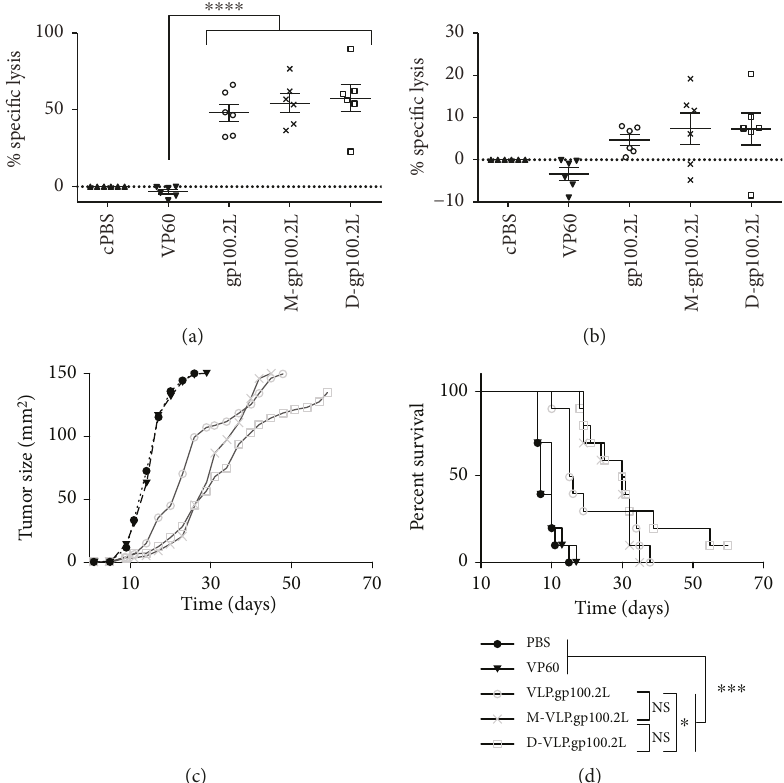
Figure 4: In vivo evaluation of mannosylated gp100 VLPs. n = 6 mice were vaccinated on day 0 and 21 with 100 μ g VLP or cPBS negative control, each including 25 μ g CpG. On day 28, mice were injected with 1 × 10 7 fl uorescently labelled target cells, either pulsed with human gp100, murine gp100 peptide or left unpulsed. Mice were culled 40 hr after target cell injection, and target cells were analysed. Percentage of speci fi c lysis of (a) human gp100 and (b) murine gp100 target cells normalised against the cPBS group. Statistical signi fi cance displayed is the comparison between VP60- and gp100-vaccinated mice as determined by one-way ANOVA with Tukey ’ s post hoc tests, ∗∗∗ p < 0 001 . n = 10 mice were injected s.c. with 5 × 10 5 B16.gp33 tumour cells. On day 5, mice were vaccinated with 100 μ g VLP or cPBS negative control, each including 25 μ g CpG. The graphs show the (c) mean tumour growth rate or (d) survival proportions. Signi fi cance was determined using a log-rank (Mantel-Cox) test, ∗∗∗ p < 0 001 , ∗ p < 0 1